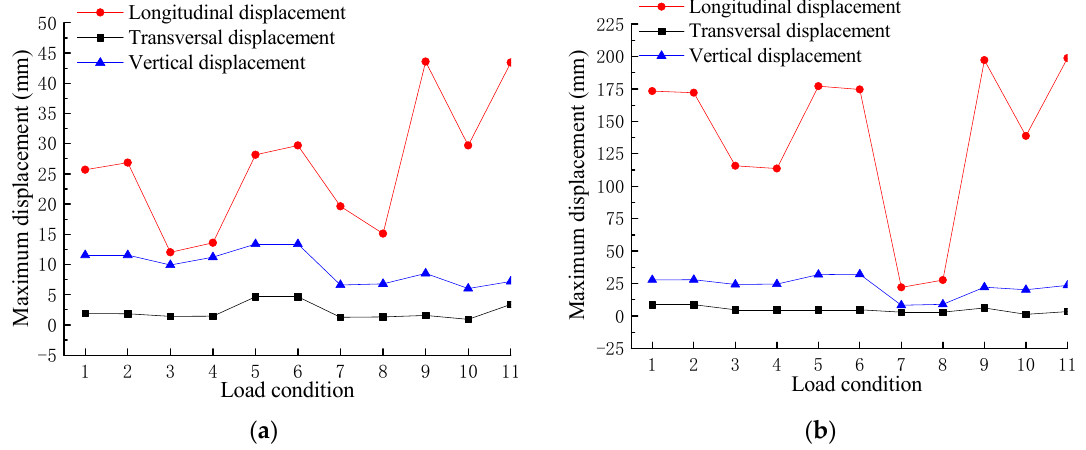
Figure 17. Maximum displacement of the tower top under each load condition: ( a ) left bank; ( b ) right bank. The transversal and vertical displacements of the towers on both banks are relatively smaller and the difference in values is not significant, but the maximum longitudinal displacement on the right bank is significantly larger than that on the left bank. The maximum longitudinal displacement of the tower at the right bank is about 150 mm more than that at the left bank because the angle between the main cable behind tower and the horizontal plane is 34.1 ◦ , which is relatively large, and the cable system generates a larger horizontal thrust to the tower. The maximum longitudinal displacement of both banks occurs under the action of load condition 9; when the initial tension of wind cable, buckle